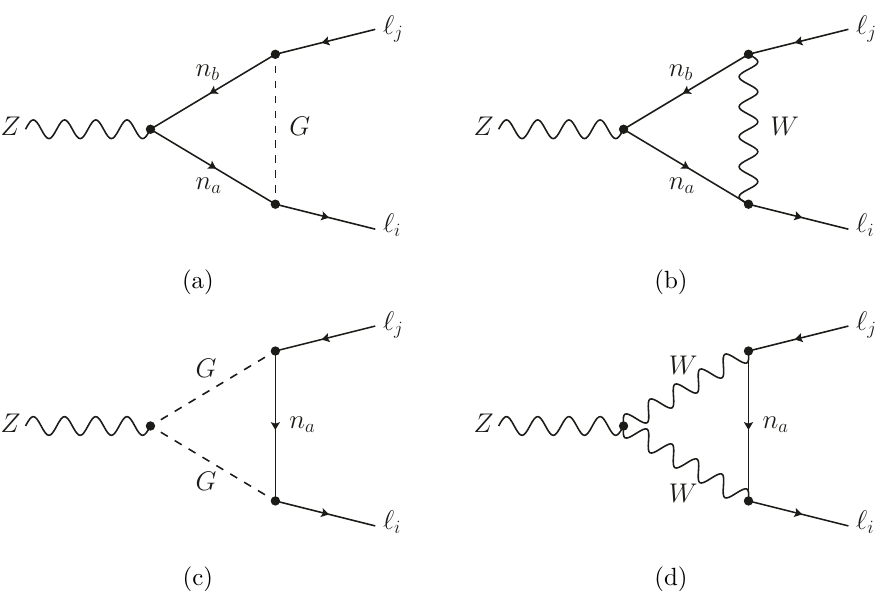
Figure 8. Diagrams contributing to the Z‘‘ 0 coupling at the one-loop level. Here n a and n b correspond to neutrino mass eigenstates. The formulae in the main text are obtained by expanding the amplitudes corresponding to these diagrams in v 2 /M 2 , i.e. they are given in the seesaw limit. R The unexpanded results are given in appendix